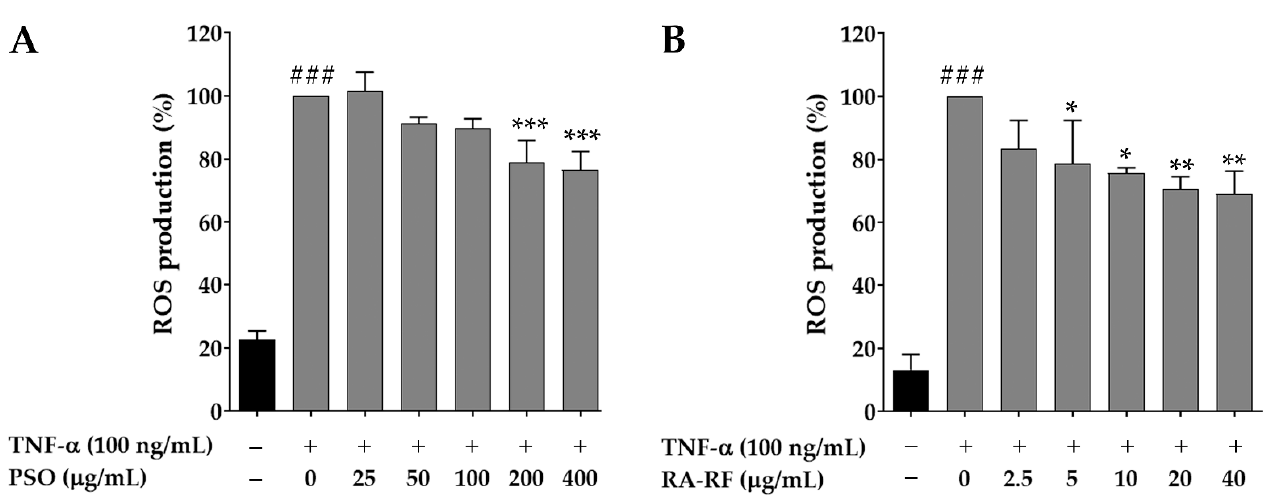
Figure 4. Treatment with PSO ( A ) and RA-RF ( B ) reduced ROS levels in TNF- α -treated A549 cells. All assays were performed in triplicate; data are presented as mean ± standard deviation ( ### p < 0.001 vs. the control group; * p < 0.05, ** p < 0.01, *** p < 0.001 vs. (+) TNF- α induced group).